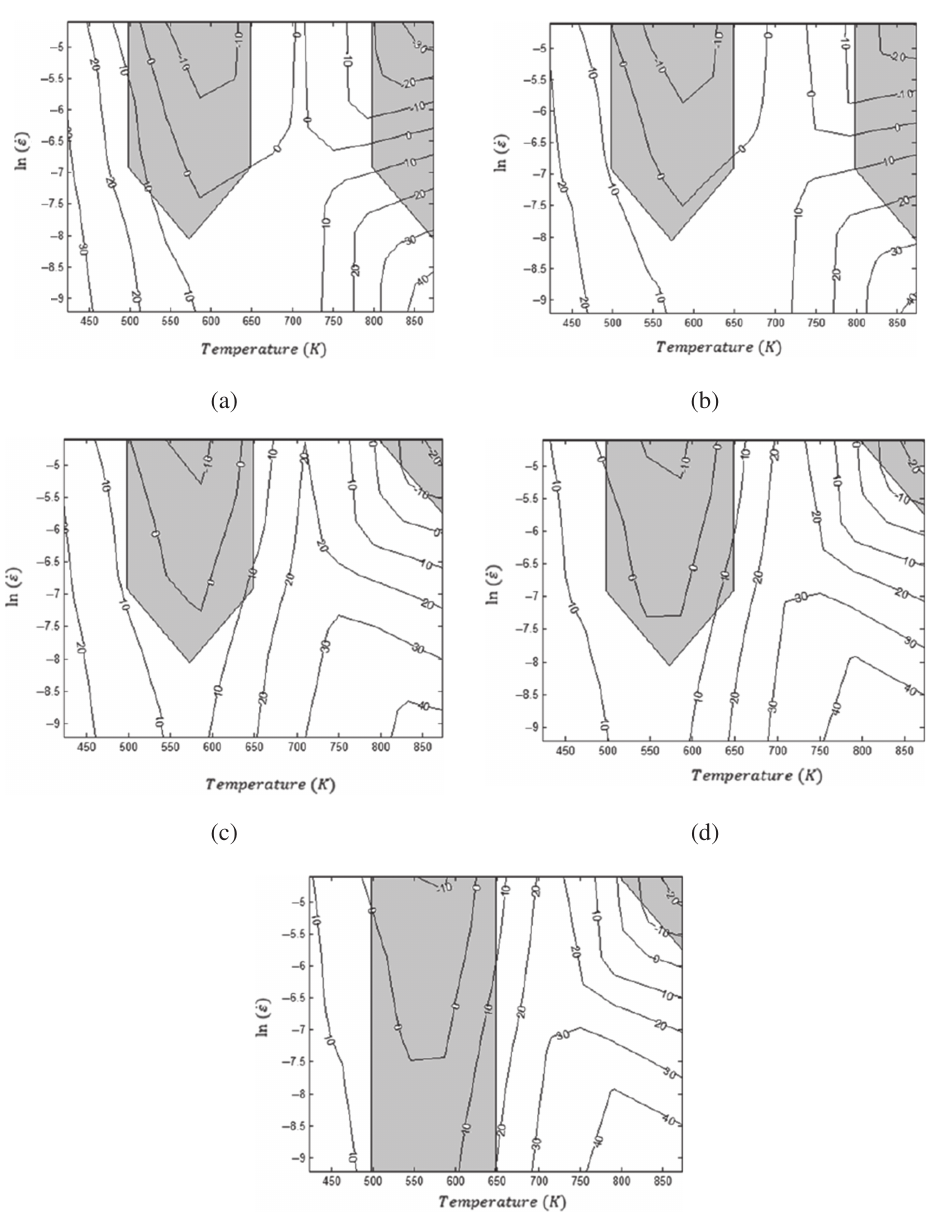
Figure 9: Processing maps of ASS 304 under different strain levels (a) 0.4 (b) 0.8 (c) 0.12 (d) 0.16 (e)